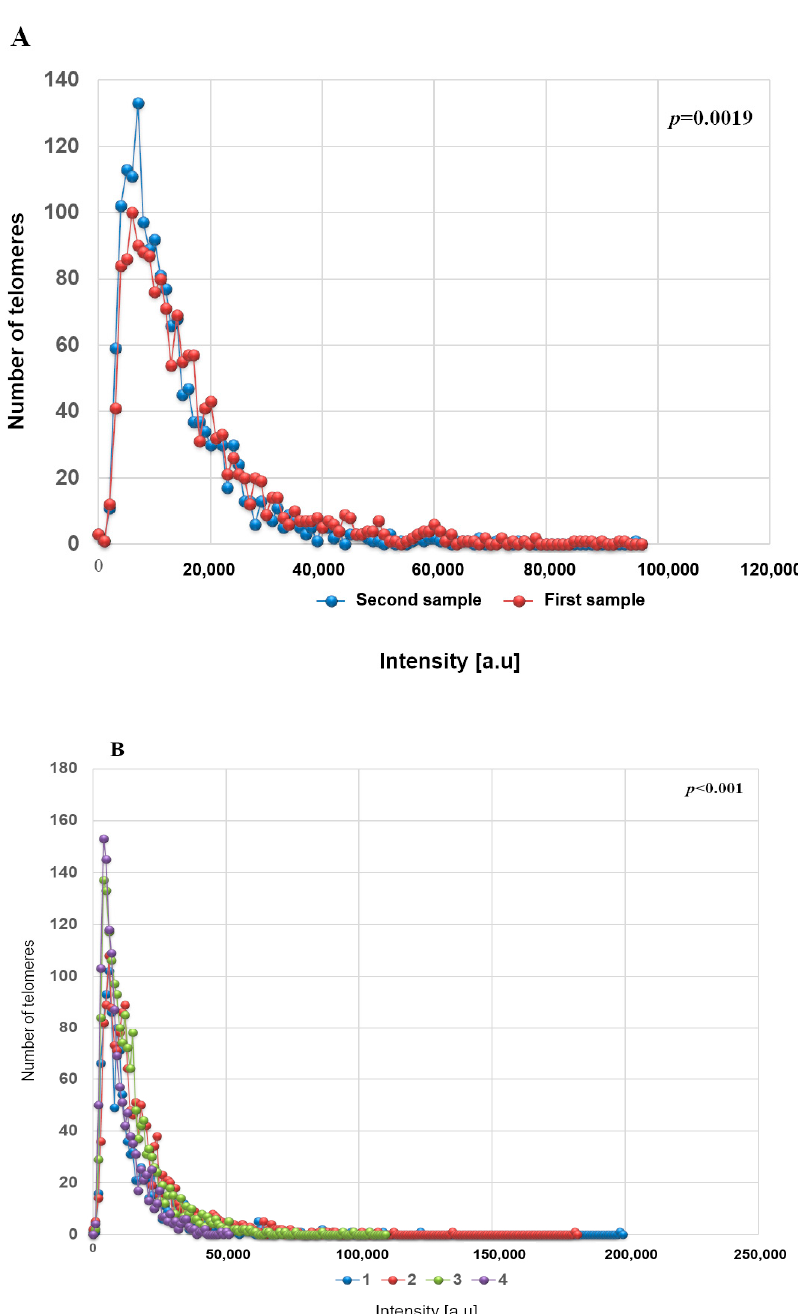
Figure 2. Telomere intensities change with disease progression ( A , B ). ( A ) First sample (red) obtained at time of diagnosis and second sample (blue) obtained during later follow-up show distinct profiles with respect to the telomere intensities and number of telomeres in the low-intensity range. Patient number 7. ( B ) First sample (1) obtained at time of diagnosis and next samples (2, 3 and 4) obtained during later follow-up after cytogenetic evolution. p -values included in each graph indicate the significance when comparing the first with the last sample. (first time point with last time point collected) Patient number 1. p values for all other comparisons are shown in Supplementary Table